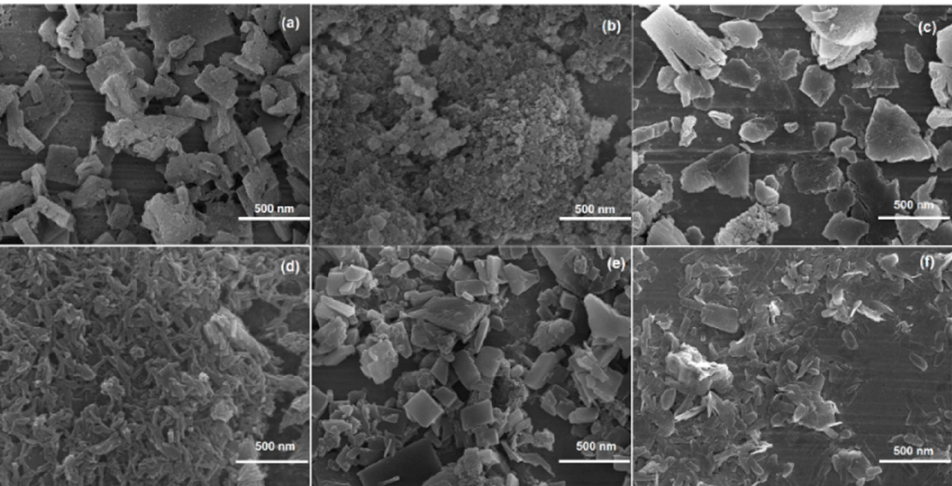
Figure 6. FE-SEM images depicting the morphology of ionic complexes derived from compound 1 .